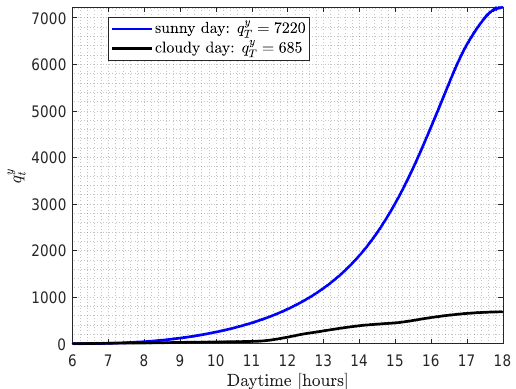
Figure 4. Pressure fields ( q y